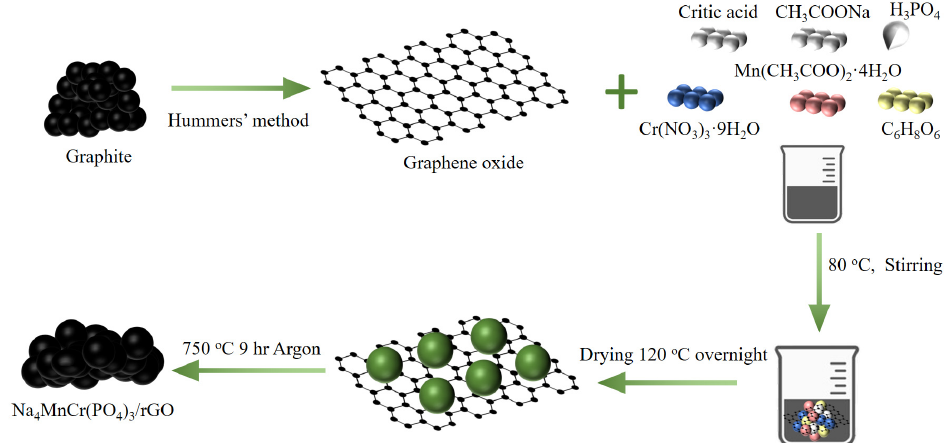
Figure 1. Illustrations of the Hummers’ method and the sol-gel process for preparing Na 4 MnCr(PO 4 ) 3